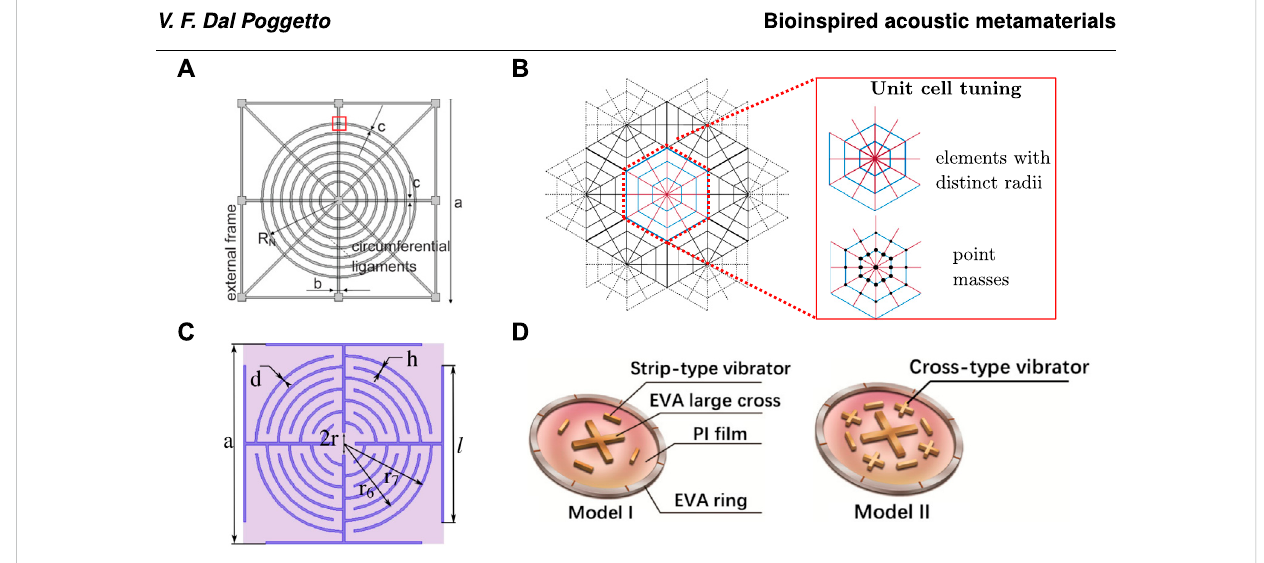
FIGURE 4 Spider web-inspired PCs and MMs. (A) MM with an external frame supporting radial and circumferential ligaments [reprinted from (Miniaci et al., 2016b), with the permission of AIP Publishing]. (B) Spider web-inspired hexagonal lattice obtained from the repetition from the unit cell, highlighted by dashed red lines, with radial (red continuous lines) and spiral-like elements (blue lines); the inset represents the possibilities of tuning in the unit cell, i.e., the cross-section of elements and included point masses [adapted from (Dal Poggetto et al., 2021) with permission from Elsevier]. (C) Labyrinthine acoustic MM composed of solid aluminum walls and air, respectively shown in blue and purple [adapted from (Krushynska et al., 2017)]. (D) Membrane-type acoustic MMs with a thin fi lm fi xed to a circumferential substrate and additional fi xed elements [adapted from Huang et al.